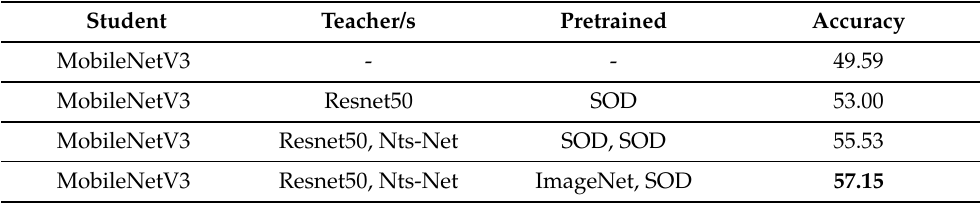
Table 4. We report the results after 200 epochs of a MobileNetV3 with a classical teacher and with